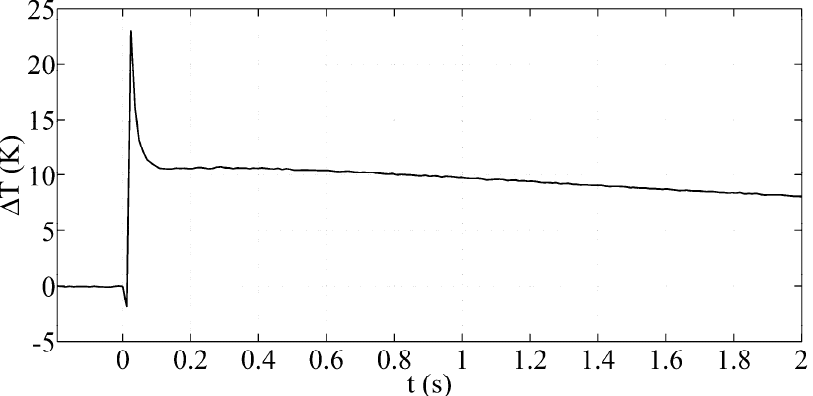
Figure 15. ∆ T plot in time in a central point of the CFRP specimen of Figure 13.